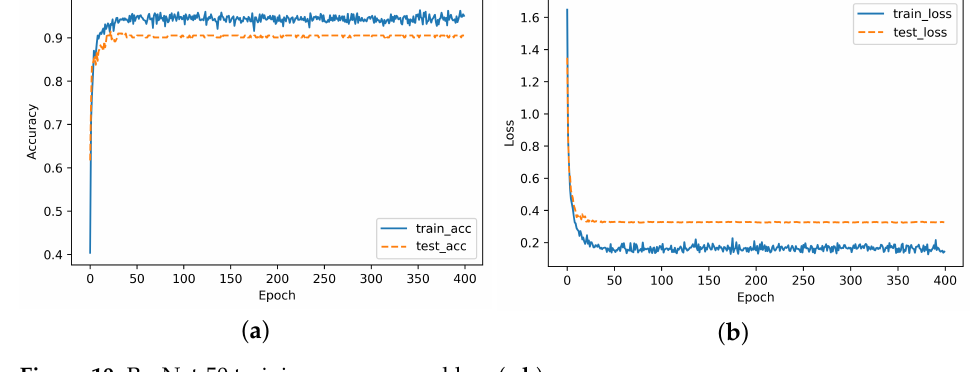
Figure 10. ResNet-50 training accuracy and loss ( a , b ).